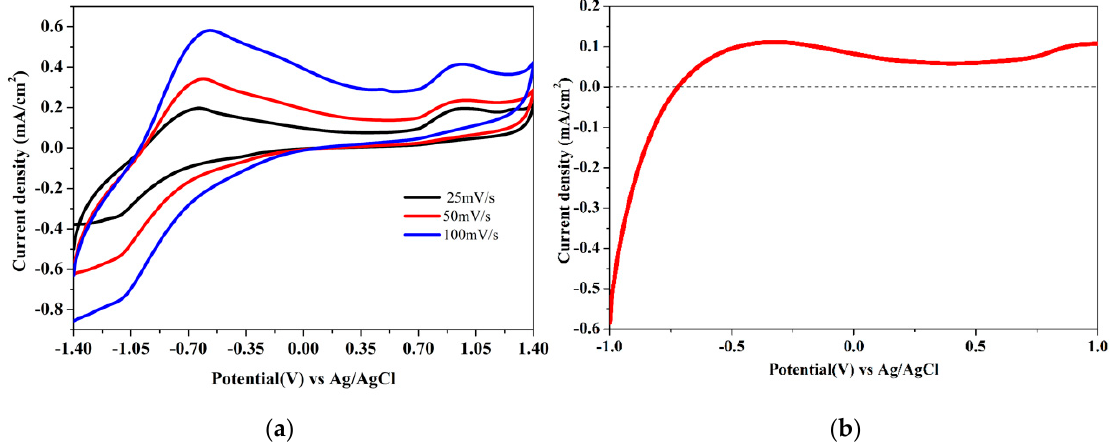
Figure 7. ( a ) Cyclic voltammograms (CV) of the MIONPs and ( b ) Linear sweep voltammetry (LSV) obtained for MIONPs in 0.5 M KOH.